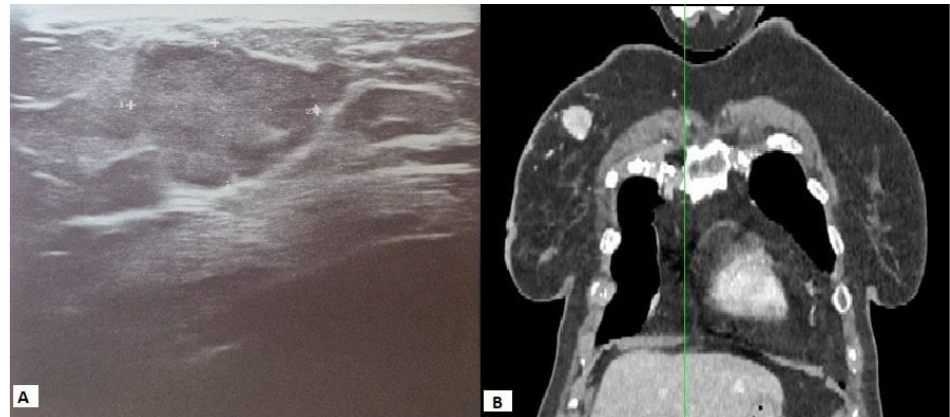
Figure 2. Ultrasound of the right breast showing an oval lobulated lesion of 19 × 18 mm with strong vascularisation, without posterior acoustic phenomena ( A ); multislice CT scan of the chest showing the right breast’s hypervascular tumour of 2.2 × 2.4 cm, whereas the axillae were without significant lymph nodes ( B ).